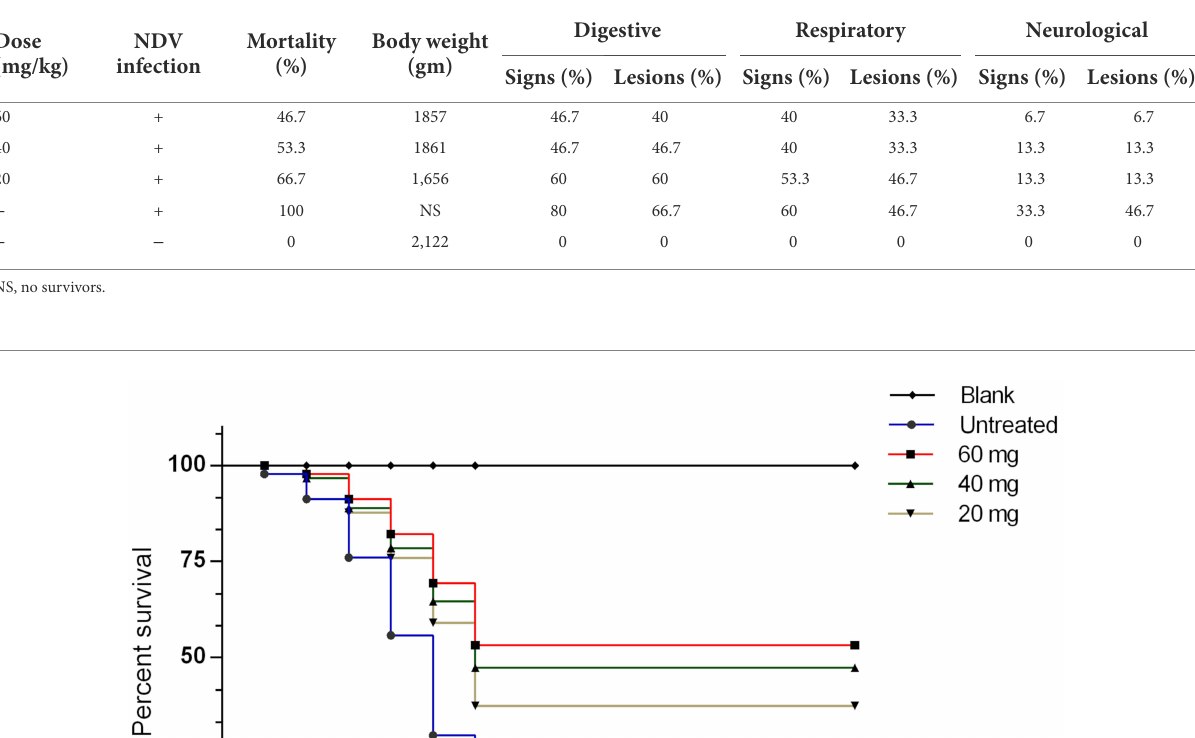
TABLE 1 Effect of 20, 40, and 60 mg/k.g BW n -docosanol treatment on the mortality percent, final body weight gain, clinical signs, and postmortem lesions of experimentally NDV-infected chickens.